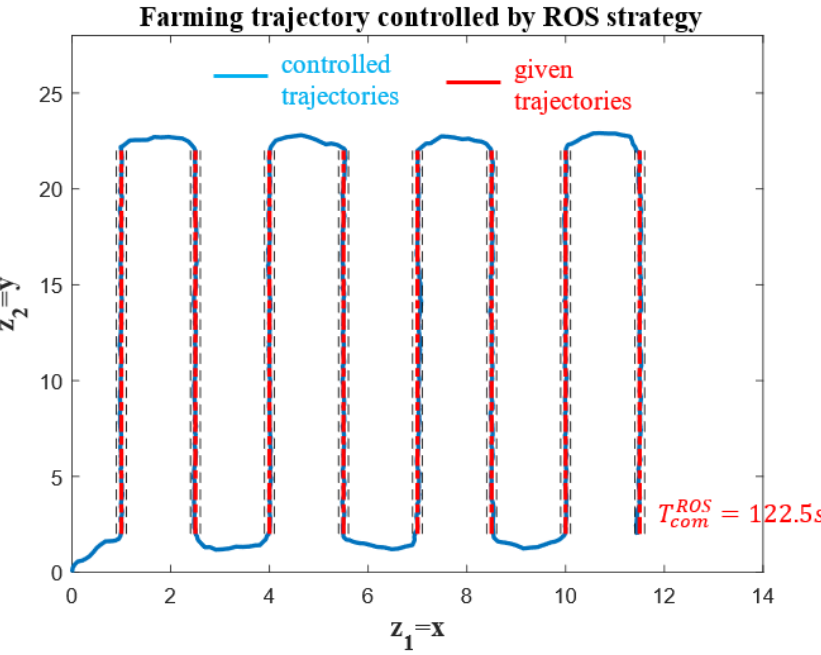
Figure 11. The working trajectory of an autonomous vehicle controlled by the ROS strategy. In addition, the parameter q , used for pseudo-state z p , was q = 2 in the simulation, without further explanations. Indeed, the value of q can affect the performance of EfiMPC defined in Equation (9). If q = 0, EfiMPC will be degraded into tracking NMPC; a